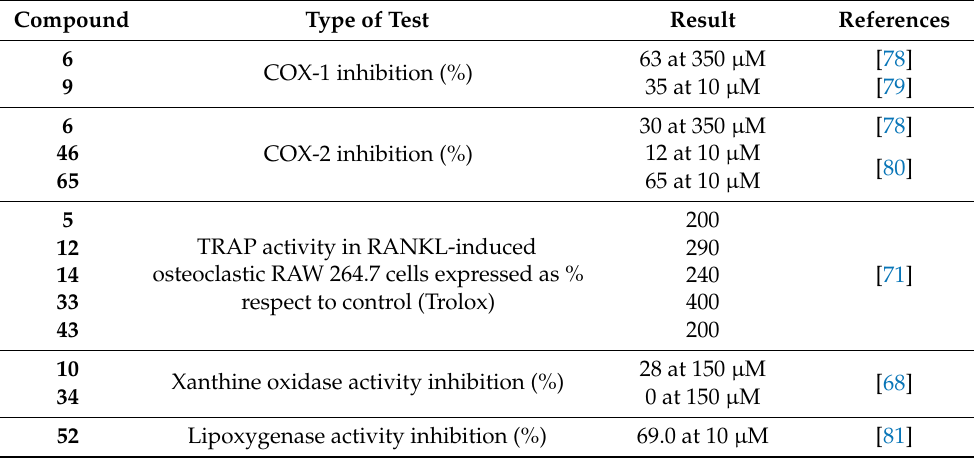
Table 6. Enzymatic activity of PMFs and